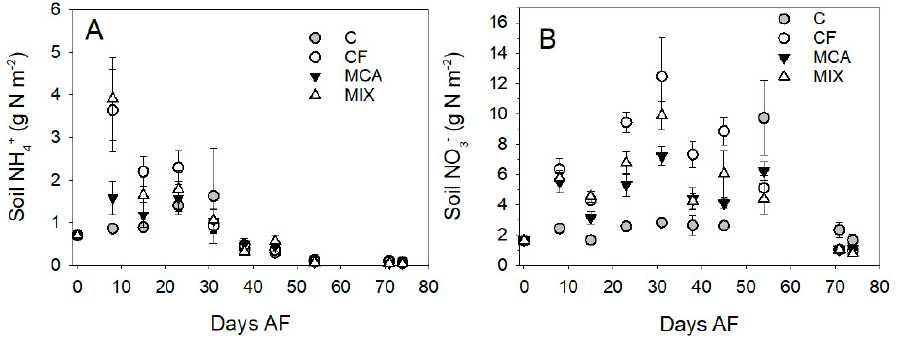
Figure 1. Soil N measured in form of available NH 4+ ( A ) and NO 3 − ( B ) in the top 10 soil centimeters of control plots and plots treated with conventional fertilizer (CF), MCA compost, and MIX. DAF stands for days after fertilization event (14 May 2013). Error bars represent one standard deviation (n = 4).